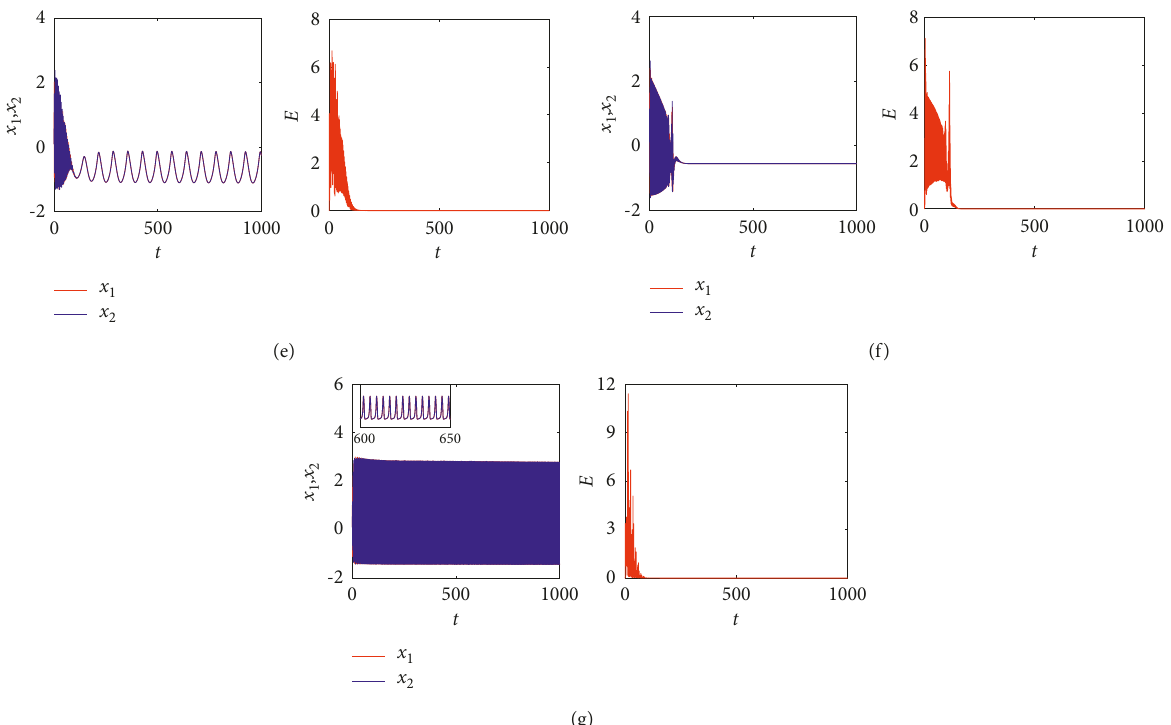
Figure 14: The time series of membrane potentials x (red line) and x (blue line), and error functions of the coupled model at case 4 1 2 (bursting and spiking neurons). For (a) bursting firing synchronization with τ � 0 . 01 and D � 5; (b) bursting firing synchronization with τ � 0 . 1 and D � 1; (c) spiking firing synchronization with τ � 0 . 1 and D � 11; (d) quiescent state synchronization with τ � 0 . 1 and D � 13; (e) spiking firing synchronization with τ � 0 . 5 and D � 2; (f) quiescent state synchronization with τ � 0 . 5 and D � 5; and (g) periodical firing synchronization with τ � 3 and D � 4. The initial values are selected with (0.1, 0.01, 1.05, 0.1, 0.01, 1.05).